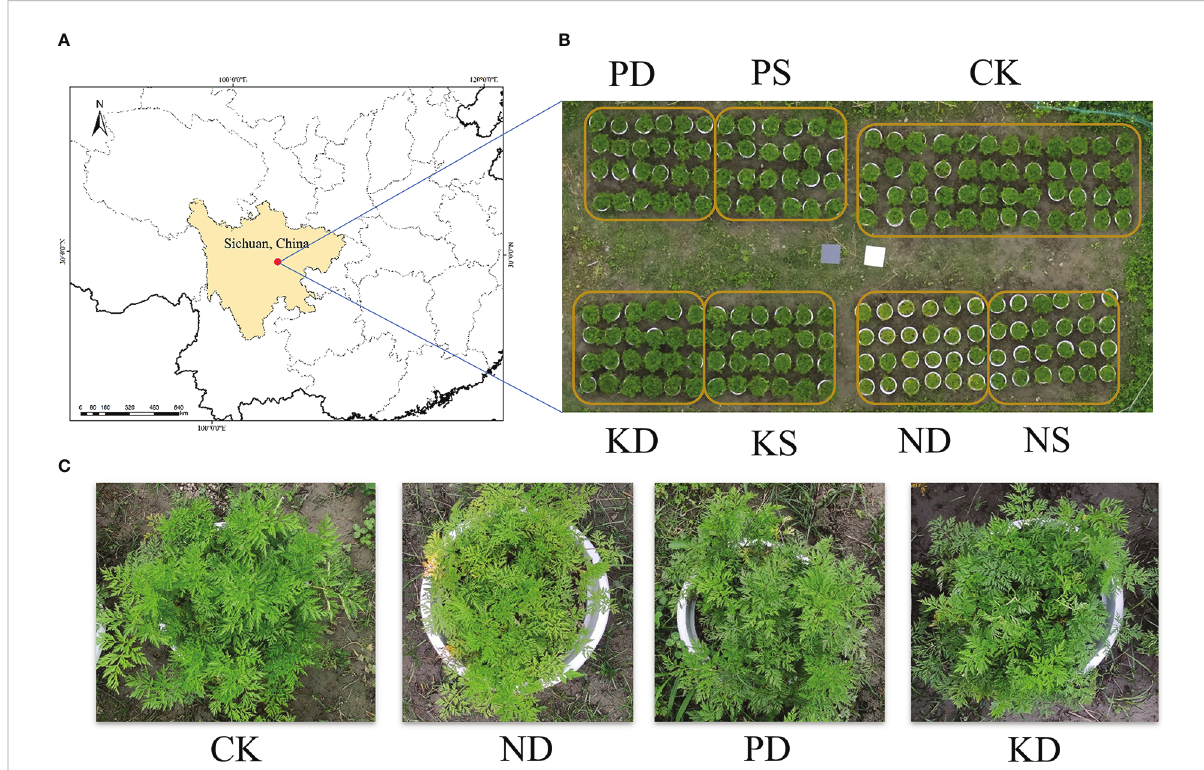
FIGURE 2 Study site, experimental design, and stress characterization. (A) Study area location, (B) Study area, (C) , Stress characterization. CK, control group, ND, nitrogen de fi ciency group, PD, phosphorus de fi ciency group, KD, potassium de fi ciency group, NS, nitrogen supplementation group, PS, phosphorus supplementation group, KS, potassium supplementation